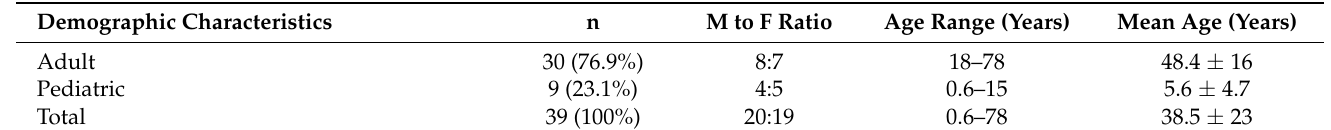
Table 1. Patients’ demographics in MRSA pericarditis